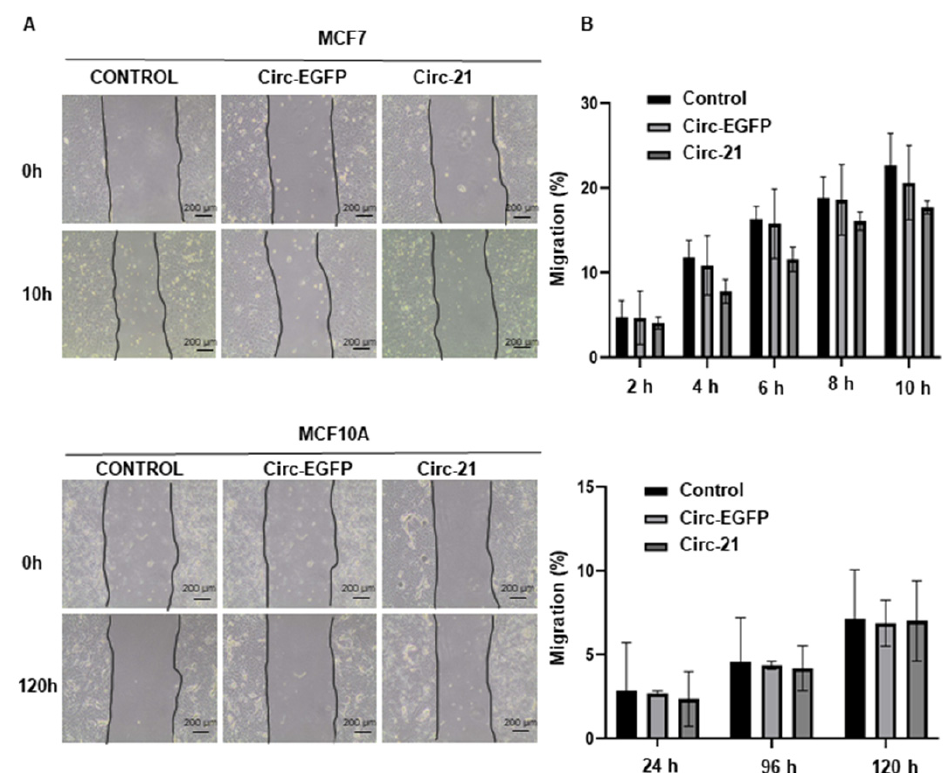
Figure 4. The Circ-21 inhibited breast cancer cell migration. ( A ) Representative microscopy images showing the wound-healing of the MCF7 and the MCF10A cells transfected with Circ-21, Circ-EGFP or no transfected; ( B ) Graphic representation of the percentage of the MCF7 and the MCF10A cells migration (area of the scratch) for the different conditions at different times. The least migration was observed in the Circ-21 MCF7 cells. Values represent means ± SD ( n = 3).